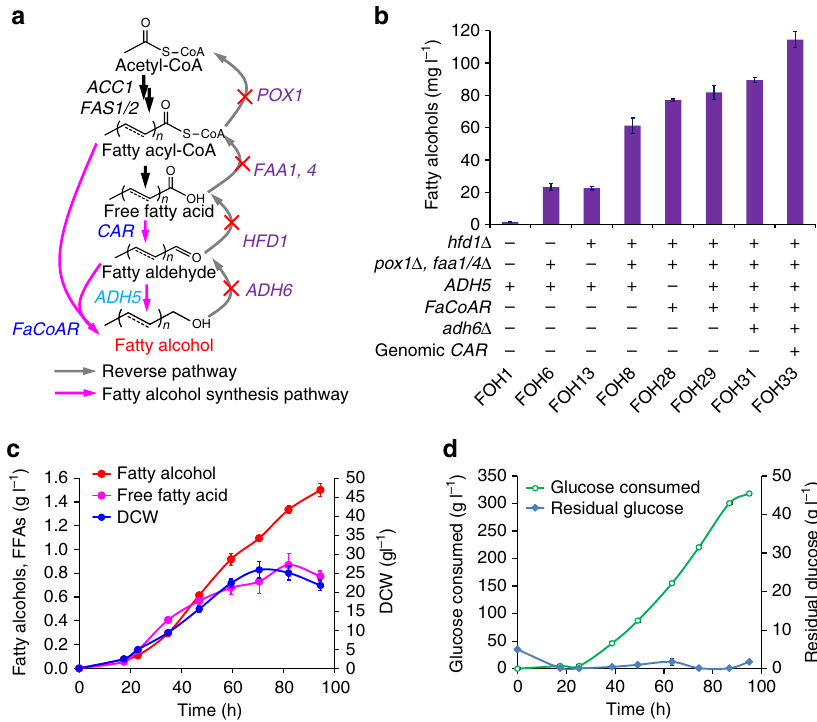
Figure 5 | Engineering fatty alcohol production from FFAs. ( a ) The rewired metabolic pathways for fatty alcohol production. Genes responsible for reverse reactions were deleted (marked with X), and genes related to fatty alcohol synthesis pathways were (over)-expressed. ( b ) Production of fatty alcohols in engineered strains in shake flasks, after 72h cultivation at 200r.p.m., 30 (cid:2) C. All data represent the mean ± s.d. of biological triplicates. ( c ) Fed- batch fermentation of the best fatty alcohol producing strain FOH33 in 1l bioreactor. ( d ) Glucose consumption profile and time courses of residual glucose during fed-batch fermentation. The data represent the mean ± s.d. of duplicates.